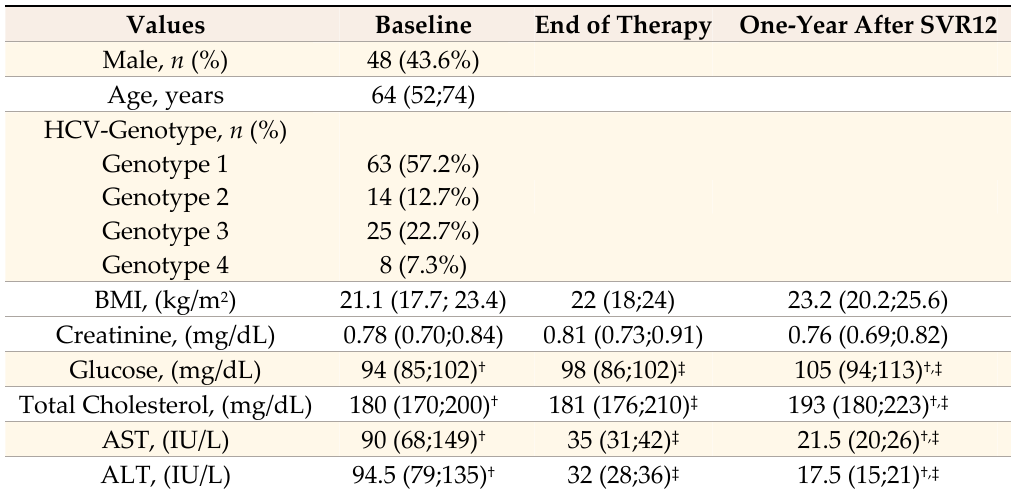
Table 1. Patients’ laboratory values prior to treatment, end of treatment, and one year after SVR 12. † represents a p <0.001, expressed as a comparison between baseline and one-year after SVR12; ‡ represents a p <0.001 expressed as a comparison between end of treatment and one-year after SVR12. AST: aspartate aminotransferase; ALT: alanine aminotransferase; GGT: gamma-glutamyl transpeptidase; ALP: alkaline